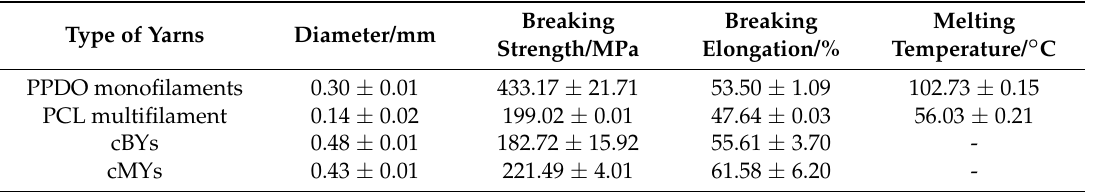
Table 1. Physical parameters of